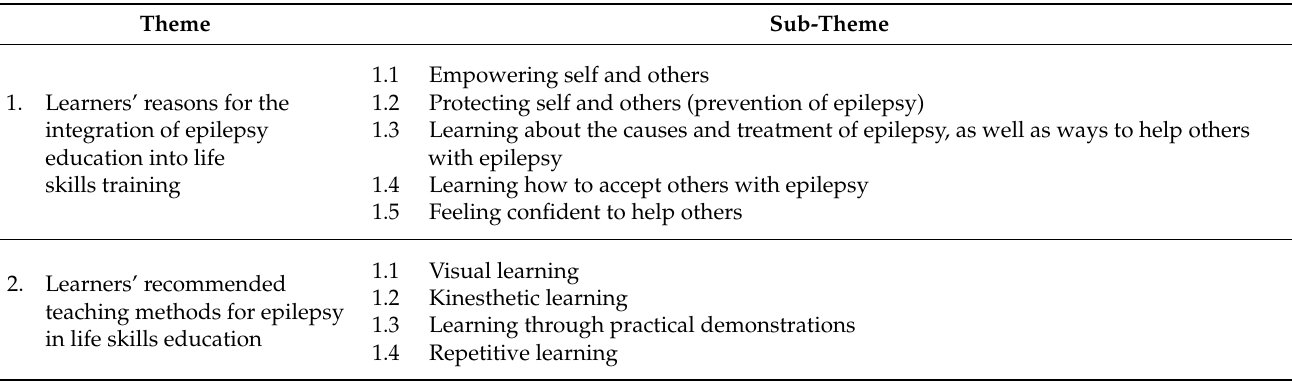
Table 1. Themes and Sub-themes of the